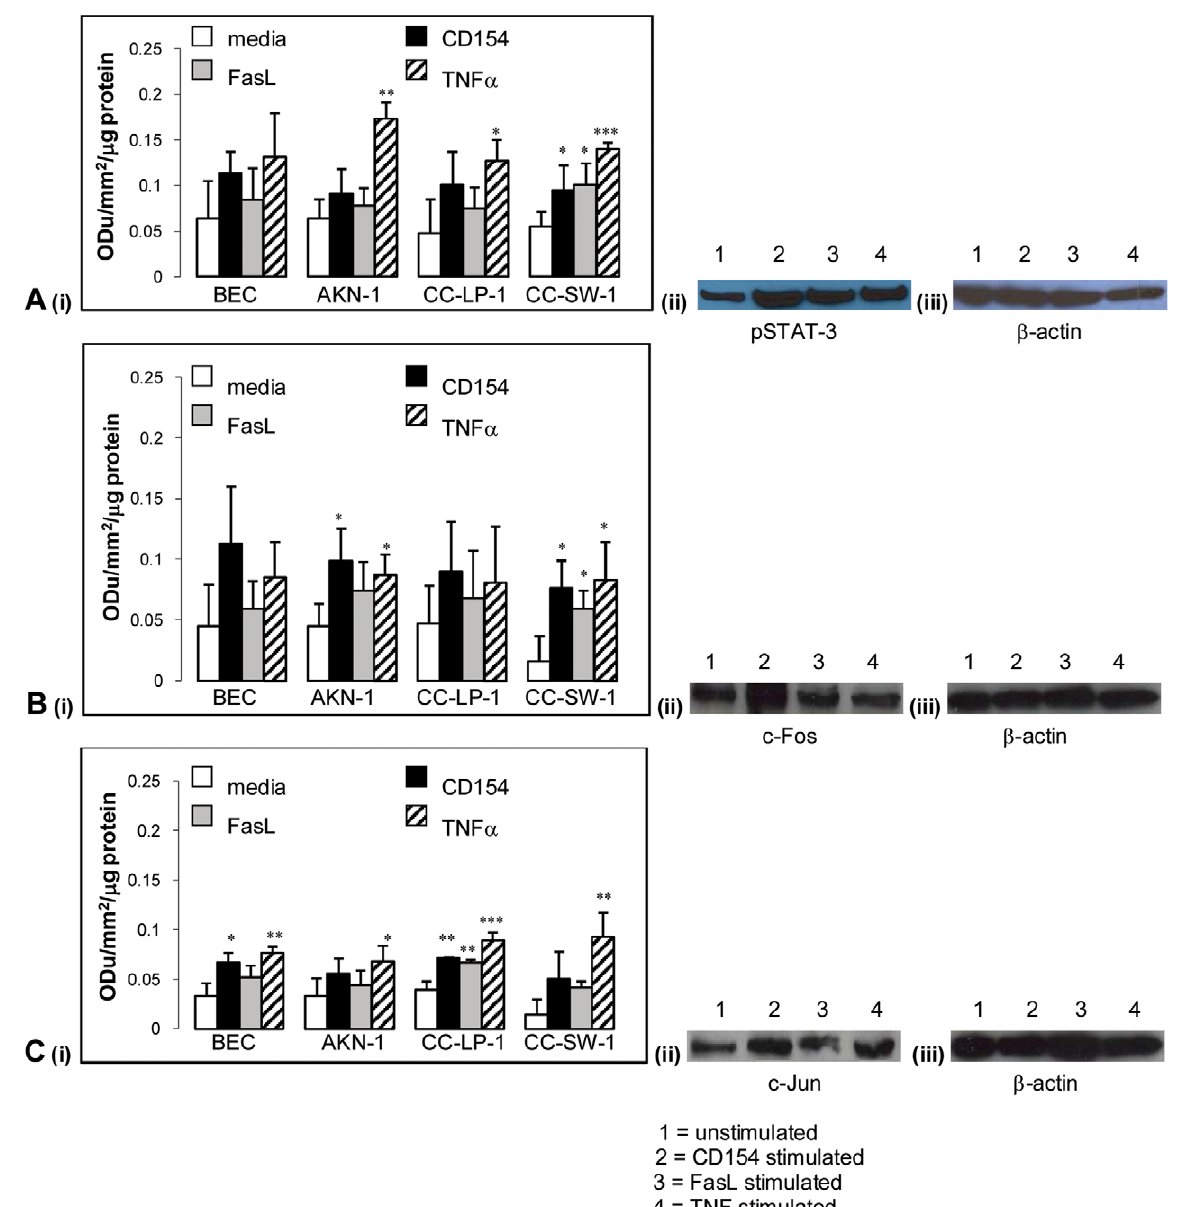
Figure 3. Transcription factor activation in cells undergoing apoptosis after stimulation with soluble TNF ligands. Cells were grown in media alone, with srh CD154 at 1 m g/ml, srh FasL at 50 ng/ml or srh TNF a at 10 ng/ml for 24 hours. Graphs show densitometry scanning data, n=3 + / 2 standard deviation and representative autoradiographs of primary cholangiocyte samples showing (a) pSTAT-3 (60 kDa), (b) c-Fos (60 kDa) and (c) c-Jun (35 kDa) all with their corresponding b -actin blots (45 kDa). *p , 0.05, **p , 0.01, ***p , 0.001 as compared to untreated